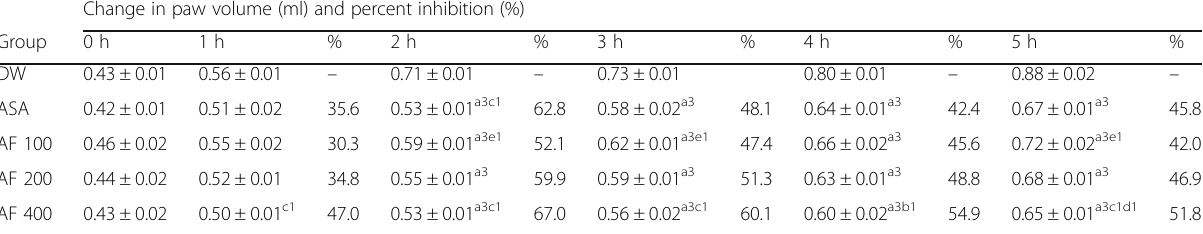
Table 6 Effect of the aqueous fraction of Moringa stenopetala on carrageenan- induced paw model and percent inhibition from increase in paw volume Change in paw volume (ml) and percent inhibition (%)